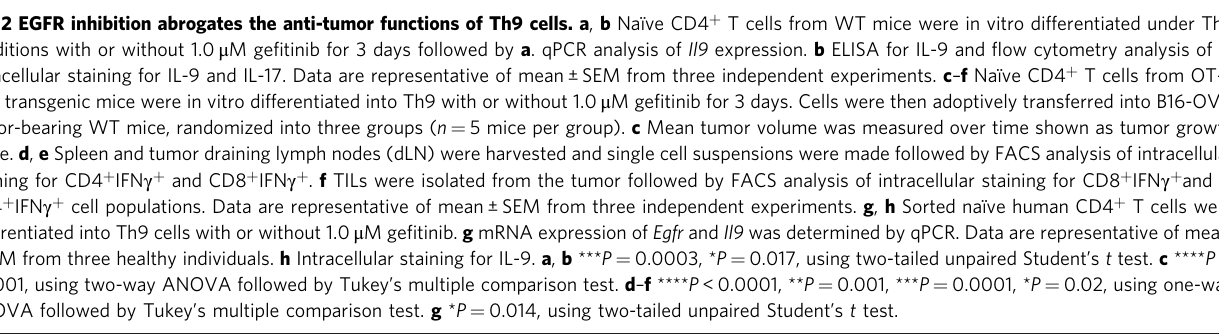
Fig. 2 EGFR inhibition abrogates the anti-tumor functions of Th9 cells. a , b Naïve CD4 + T cells from WT mice were in vitro differentiated under Th9 conditions with or without 1.0 μ M ge fi tinib for 3 days followed by a . qPCR analysis of Il9 expression. b ELISA for IL-9 and fl ow cytometry analysis of intracellular staining for IL-9 and IL-17. Data are representative of mean ± SEM from three independent experiments. c – f Naïve CD4 + T cells from OT-II TCR transgenic mice were in vitro differentiated into Th9 with or without 1.0 μ M ge fi tinib for 3 days. Cells were then adoptively transferred into B16-OVA tumor-bearing WT mice, randomized into three groups ( n = 5 mice per group). c Mean tumor volume was measured over time shown as tumor growth curve. d , e Spleen and tumor draining lymph nodes (dLN) were harvested and single cell suspensions were made followed by FACS analysis of intracellular staining for CD4 + IFN γ + and CD8 + IFN γ + . f TILs were isolated from the tumor followed by FACS analysis of intracellular staining for CD8 + IFN γ + and CD4 + IFN γ + cell populations. Data are representative of mean ± SEM from three independent experiments. g , h Sorted naïve human CD4 + T cells were differentiated into Th9 cells with or without 1.0 μ M ge fi tinib. g mRNA expression of Egfr and Il9 was determined by qPCR. Data are representative of mean ± SEM from three healthy individuals. h Intracellular staining for IL-9. a , b *** P = 0.0003, * P = 0.017, using two-tailed unpaired Student ’ s t test. c **** P < 0.0001, using two-way ANOVA followed by Tukey ’ s multiple comparison test. d – f **** P < 0.0001, ** P = 0.001, *** P = 0.0001, * P = 0.02, using one-way ANOVA followed by Tukey ’ s multiple comparison test. g * P = 0.014, using two-tailed unpaired Student ’ s t